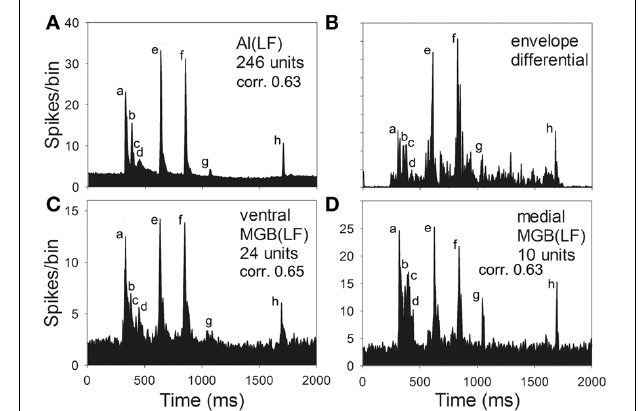
FIGURE 8 | Mean response to chutter derived from the population of low-frequency units (CF < 1.5kHz) recorded in (A) AI(LF) (C) ventral and (D) medial MGB. The mean responses all look similar to each other and to the first differential of the waveform envelope shown in panel (B) . The correlation values between each of the population responses and the first differential are also very